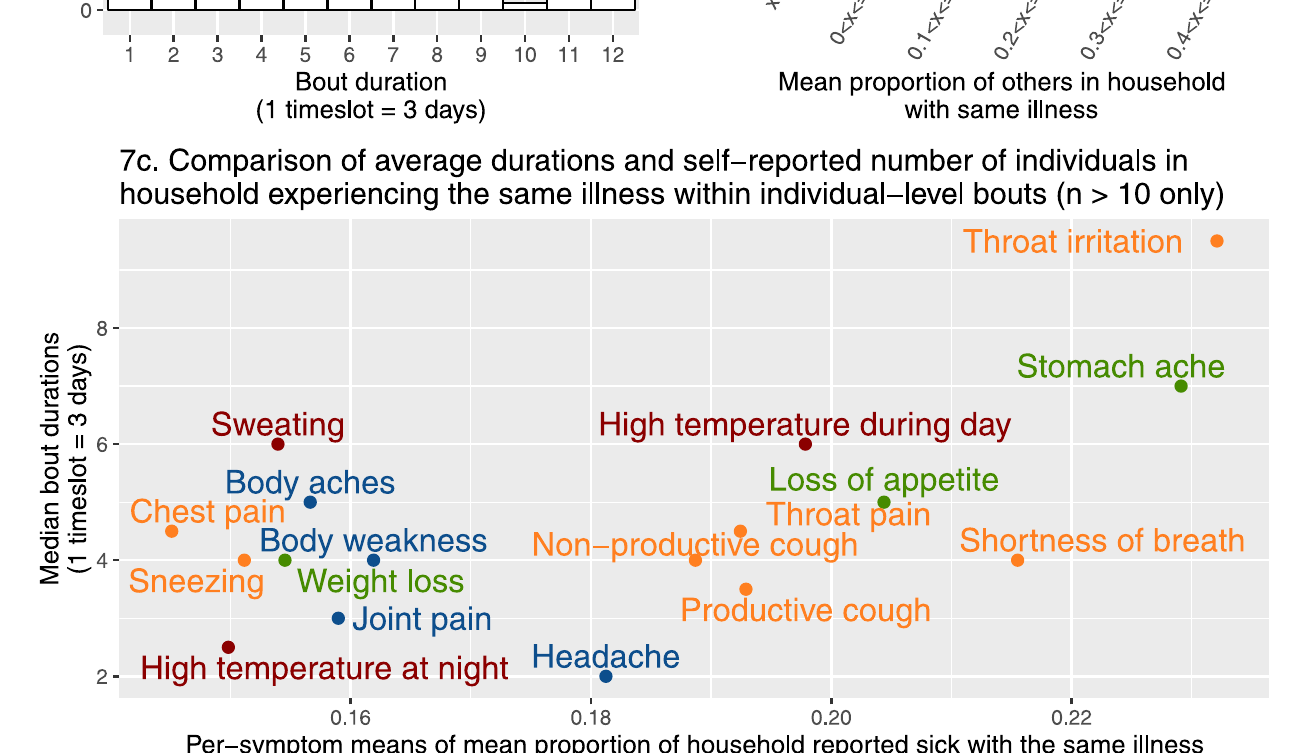
Fig 7. Between-bout comparisons. Distributions of bout duration ( 7a ) and the number of others reported to be sick with the same illness ( 7b ) during bouts of illness. Also, comparison of the means of summary statistics obtained by aggregating all bouts containing at least one mention of a given symptom — median bout duration, and mean proportion of others sick ( 7c ). This proportion was calculated using the number of individuals living in the household, which was recorded as part of the consent/assent process, and the distribution of which can be seen in S2 Fig.